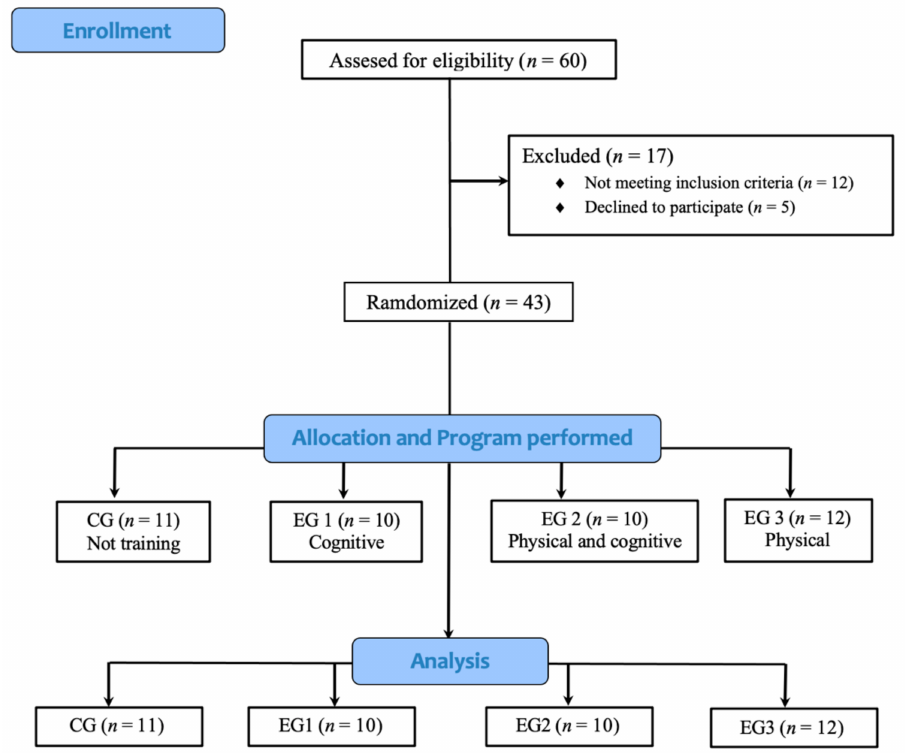
Figure 1. Participant’s recruitments